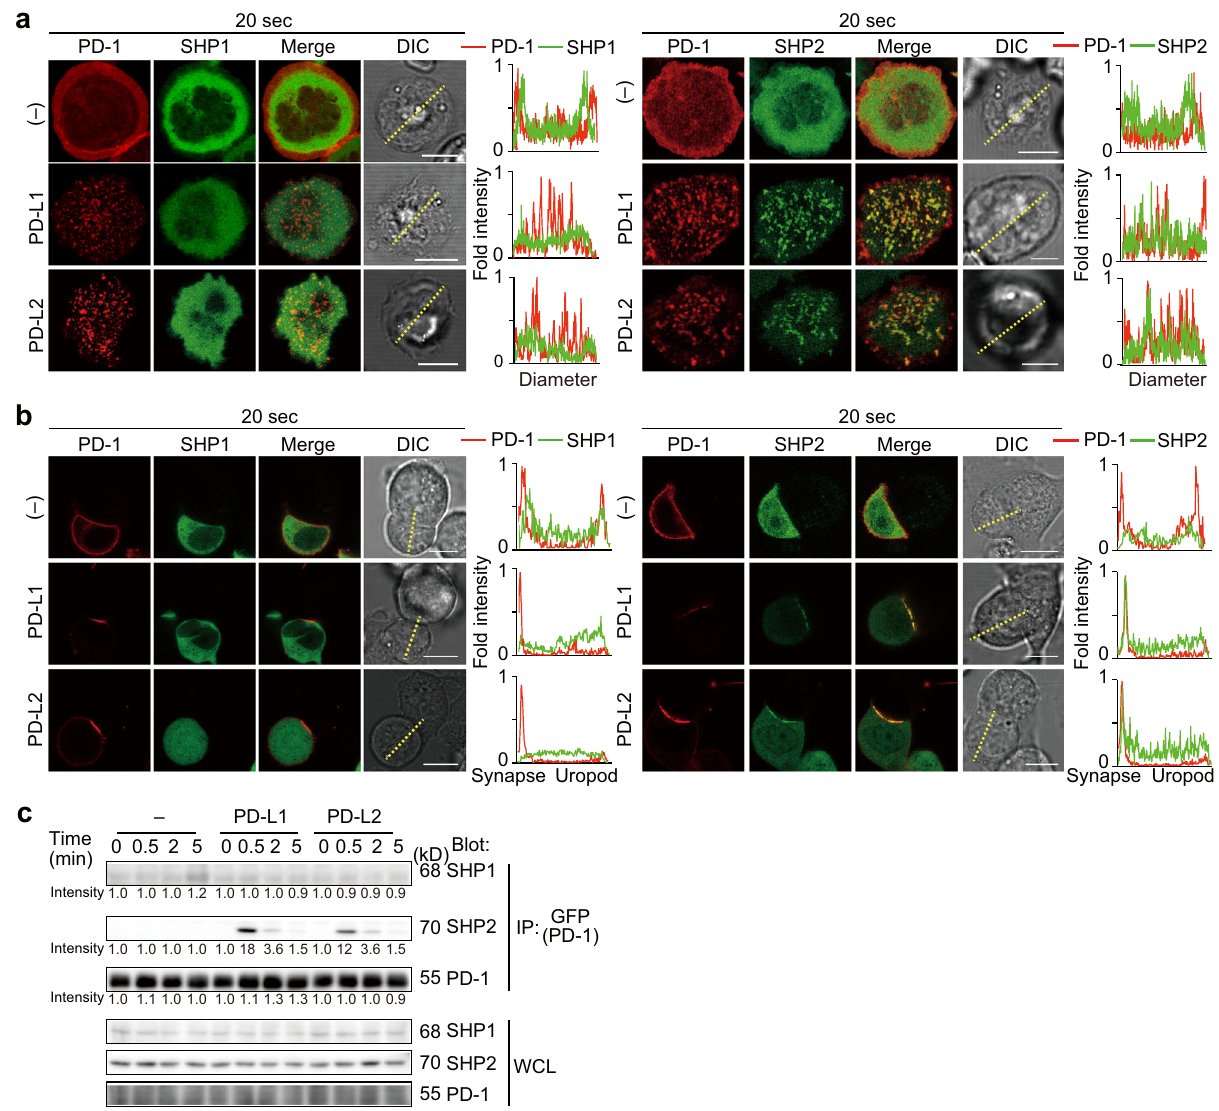
Fig. 3 SHP2, but not SHP1, is rapidly and transiently recruited to PD-1 microclusters. a 2D12 transduced with both mPD-1 – HaloTag and EGFP – SHP1 (left) or EGFP – SHP2 (right) were preincubated with the HaloTag ligand – Stella650 (red), plated onto the SLB as in Fig. 1a without (top) or with mPD-L1 – GPI (150/ μ m 2 , middle) or mPD-L2 – GPI (150/ μ m 2 , bottom) and real-time imaged by confocal microscopy at 20 s after contact. Histograms show fold fl uorescent intensities of mPD-1 (red) and SHP1 (green) or SHP2 (green) on the diagonal yellow lines in the DIC images. b The cells in a (SHP1, left panel; SHP2, right panel) were conjugated with DC-1 cells not expressing (top) or expressing mPD-L1 (middle) or mPD-L2 (bottom) and real-time imaged by confocal microscopy at 20 s after contact. Histograms show fold fl uorescent intensities of PD-1(red) and SHP1 (green, left panel) or SHP2 (green, right panel) on the diagonal yellow lines in the DIC images. c 2D12 expressing mPD-1 – EGFP were conjugated by MCC 88 – 103 -prepulsed (5 μ M) DC-1 cells (left) or DC-1 expressing mPD-L1 (middle) or mPD-L2 (right) for the indicated times. The cells were lysed, immunoprecipitated for PD-1 by anti-GFP and blotted for SHP1, SHP2, or PD-1. The whole cell lysates (WCLs) were blotted for SHP1, SHP2, or PD-1. The number below each line represents the intensity of the band. All data are representatives of three independent experiments. Bars, 5 μ endogenous expression of human (h) PD-L1 and hPD-L2 by